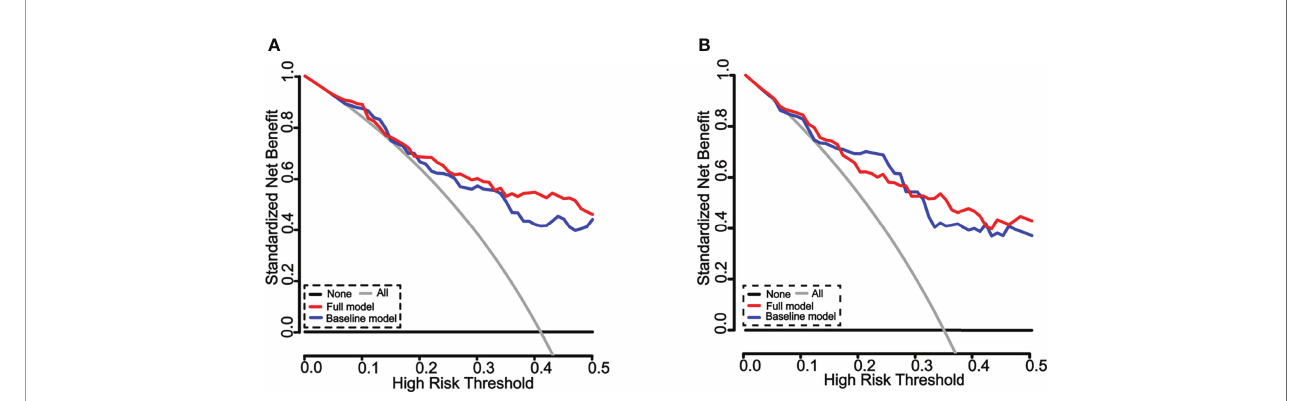
FIGURE 7 | Decision curve analysis (DCA) of the nomograms for estimation of ILD risk in RA patients. (A) DCA of the nomograms for identi fi cation of ILD in the training cohorts. The x-axis represents the threshold probability, and the y-axis represents the net bene fi t calculated by adding the true positives and subtracting the false positives. The horizontal line along the x-axis represents the patients without ILD, whereas the gray line represents the assumption that all patients had ILD at a speci fi c threshold probability. The blue line represents the nomogram created with four risk factors alone, and the red line represents the nomogram generated with the four factors with an incorporation of MMP-3. The line better matched to the diagonal gray curve indicates a better prediction. Both of the nomograms could predict the outcome of ILD in RA patients. (B) DCA of the nomograms for identi fi cation of ILD in validation cohorts. The x-axis represents the threshold probability, and the y-axis represents the net bene fi t calculated by adding the true positives and subtracting the false positives. The horizontal line along the x-axis represents the assumption of non-ILD RA patients, whereas the gray line represents the assumption that all patients had ILD at a speci fi c threshold probability. The blue line represents the nomogram with four risk factors alone, and the red line represents the nomogram generated with the four factors incorporated with MMP-3. The line better matched to the diagonal gray curve indicates a better prediction. Both of nomograms could predict the outcome of ILD in RA